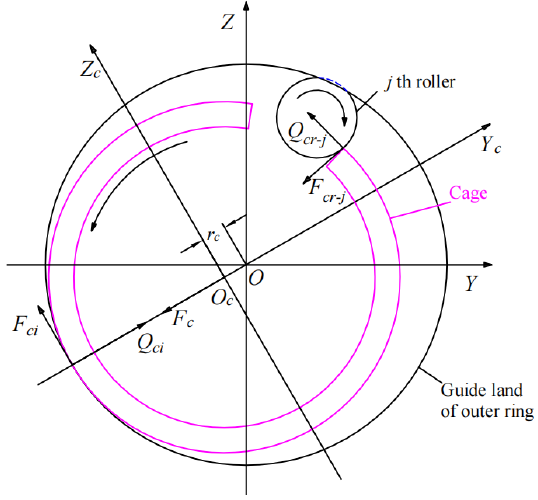
Figure 2. Schematic diagram of the force on the cage.